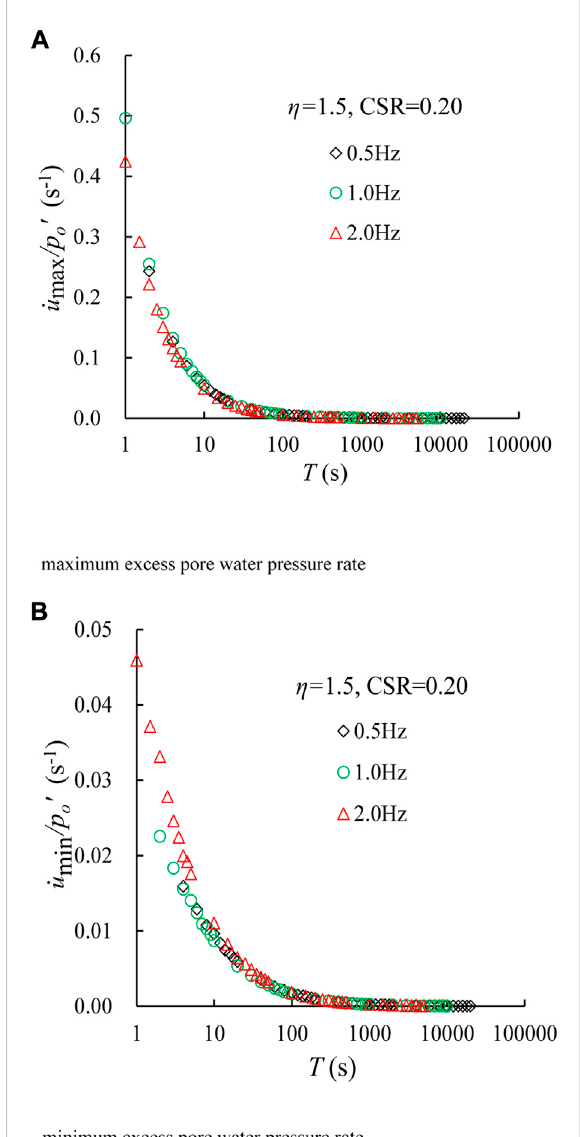
FIGURE 8 Developments of the normalized excess pore water pressure rate versus loading time under different f values for η = 1.50 and CSR = 0.20. (A) Maximum excess pore water pressure rate and (B) minimum excess pore water pressure